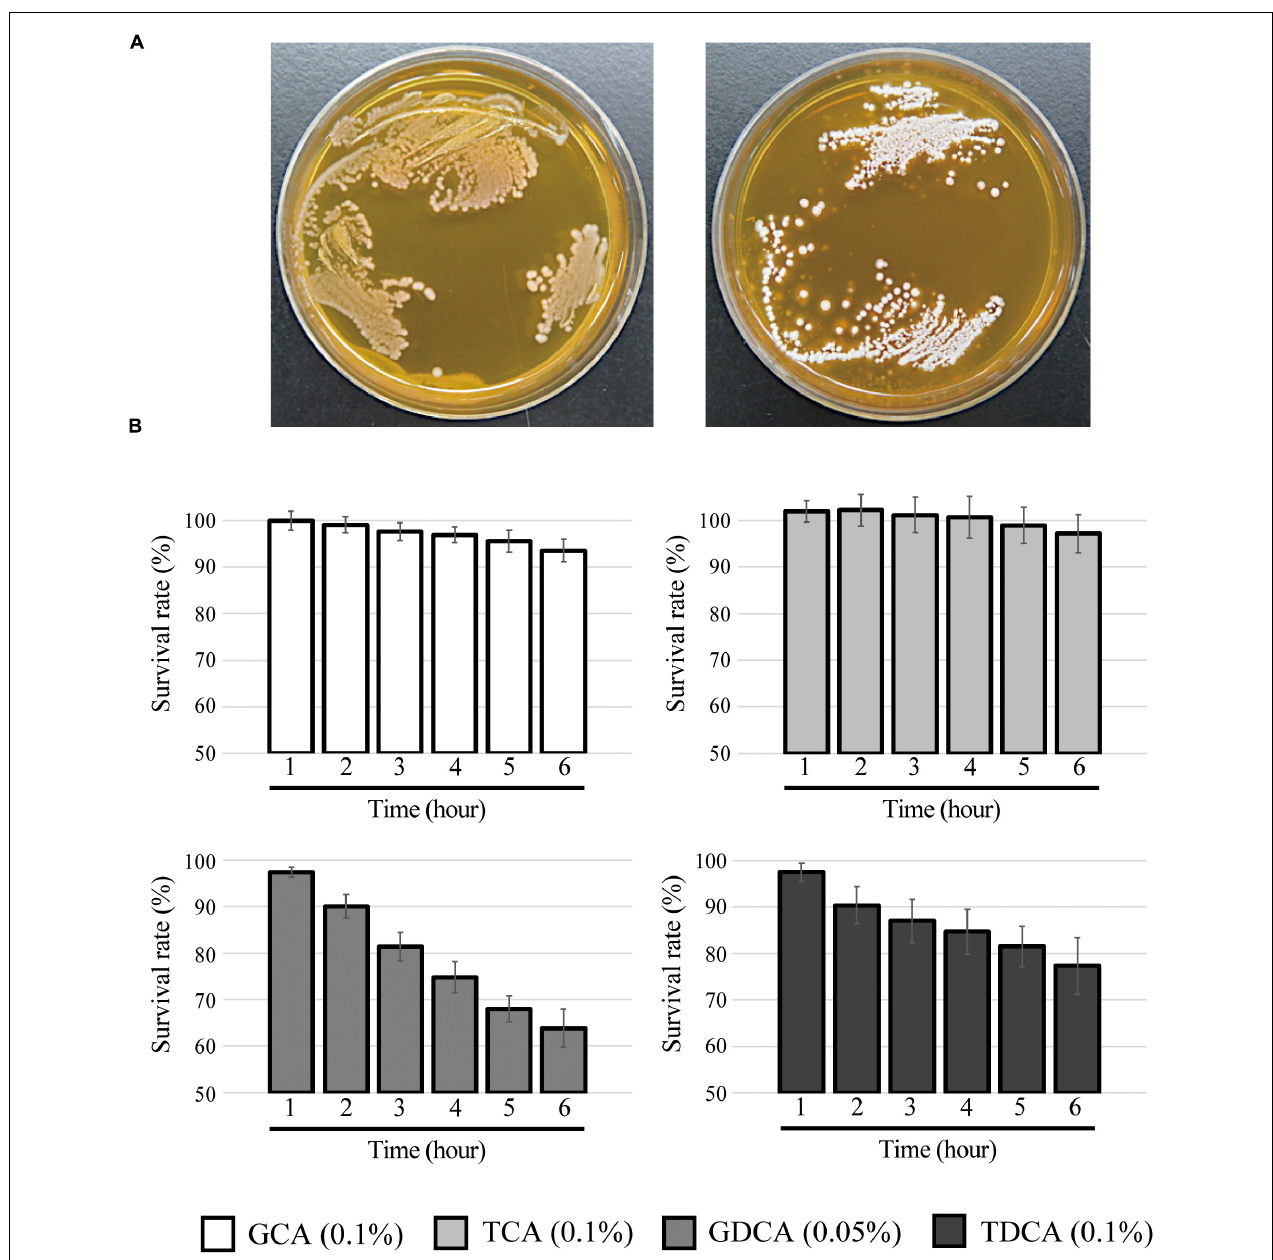
FIGURE 4 | Bile salt hydrolase and bile salt resistance activities in L. paragasseri JCM 5343 T . (A) Full-grown culture of L. paragasseri JCM 5343 T was streaked anaerobically on an MRS agar plate (left) or an MRS agar plate containing 0.25% TDCA (right). The plates were incubated at 37 ◦ C under anaerobic conditions for 3 days. (B) Overnight full-grown culture of L. paragasseri JCM 5343 T was inoculated into fresh GAM medium containing different bile salts (0.1% GCA, 0.05% GDCA, 0.1% TCA, and 0.1% TDCA) and incubated anaerobically at 37 ◦ C. The optimal density was measured every hour, and survival rates were assessed. The survival rate of control (without bile salt) was defined as 100%. Results indicated mean ± SD obtained in triplicate